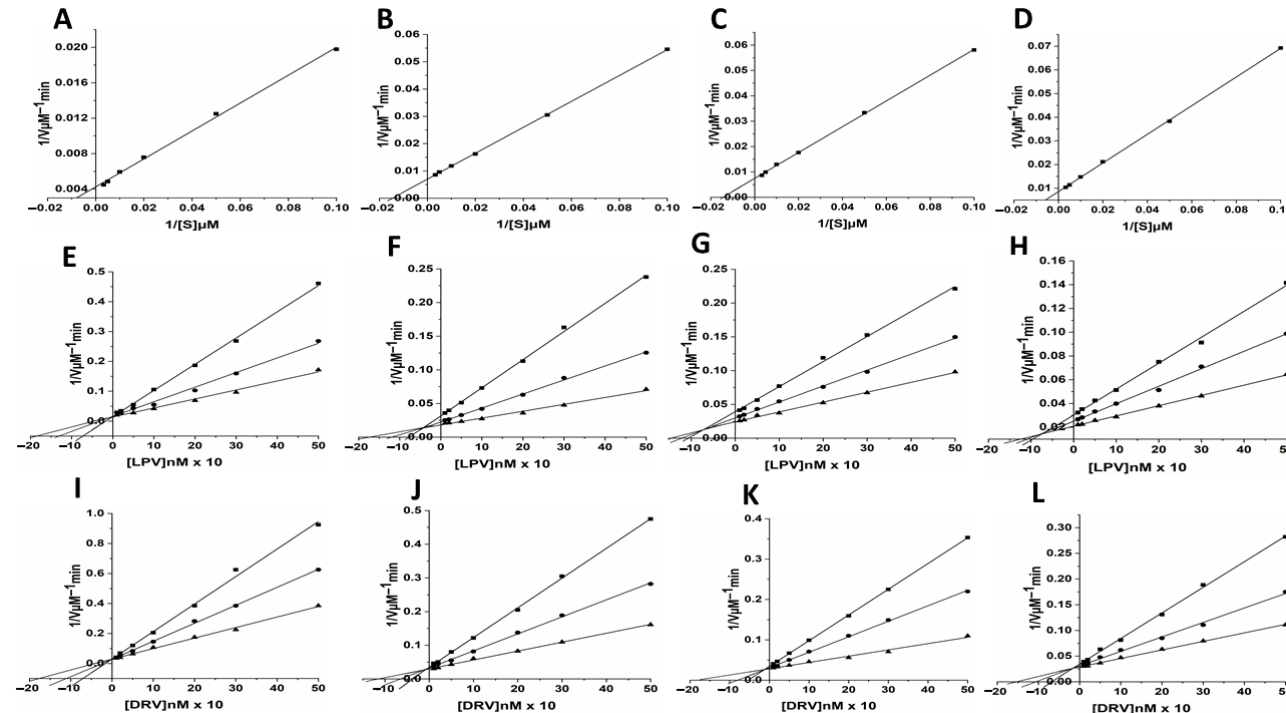
Figure 3. ( A – D ) Enzyme kinetic activity of WT ( A ) and mutant HIV-1 PR variants ( B = MUT-1, C = MUT-2, and D = MUT-3) was determined following the hydrolysis of the chromogenic synthetic substrate (Lys-Ala-Arg-Val-Nle-p-nitro-Phe-Glu-Ala-Nle amide). ( E – H ) The activity of the HIV-1 PR variants ( E = WT, F = MUT-1, G = MUT-2, and H = MUT-3) measured in the presence of 10–500 nM lopinavir (LPV) using three substrate concentration: 100 ( ■ ), 200 ( ● ), and 300 μ M ( ▲ ) respectively. ( I – L ) The activity of the HIV-1 PR variants ( I = WT, J = MUT-1, K = MUT-2, and L = MUT-3) measured in the presence of 10–500 nM darunavir (DRV) using three substrate concentration: 100 ( ■ ), 200 ( ● ), and 300 μ M ( ▲ ) respectively.